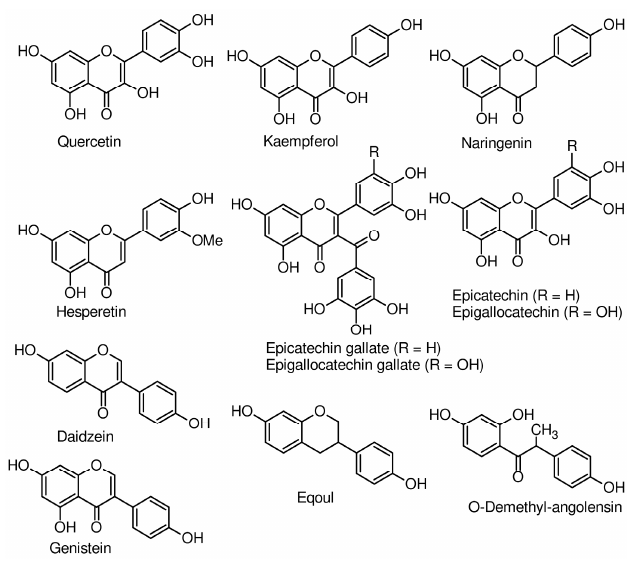
Figure 1. Chemical structures of polyphenols detected in human milk.